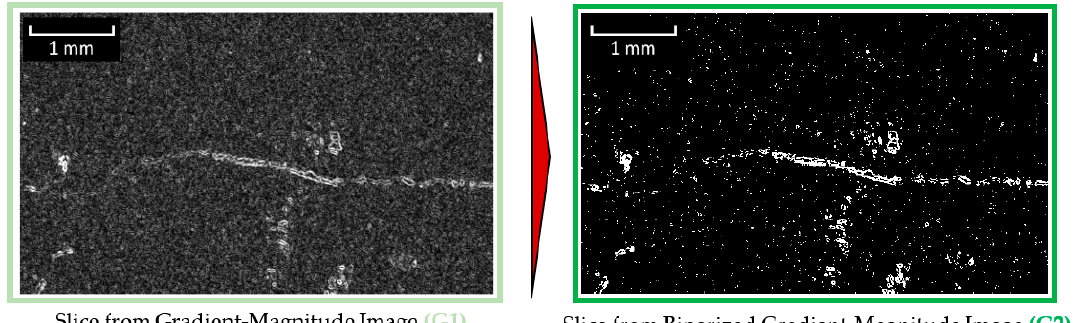
Figure 8. Binarization of the gradient image (based on figure in [10]).